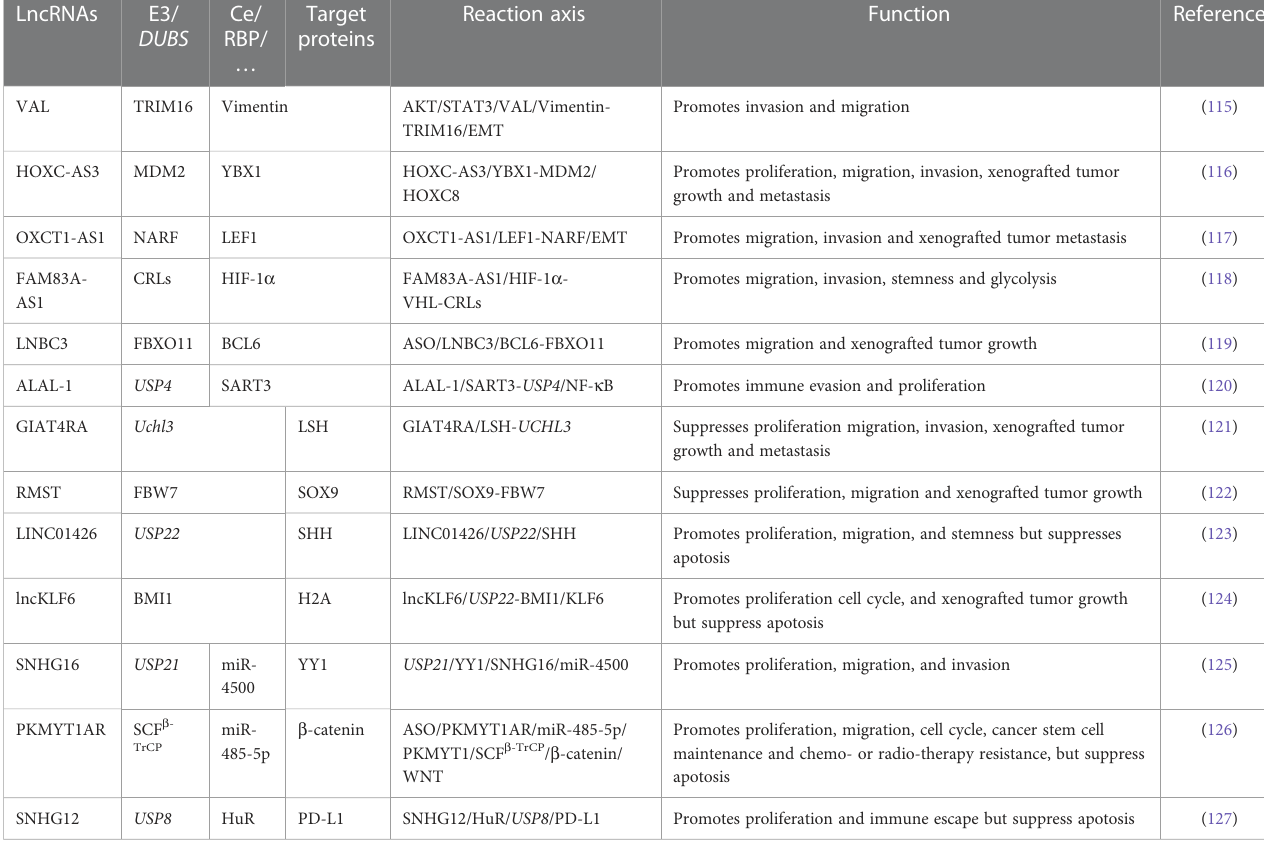
TABLE 2 The interaction between lncRNAs and UPS in NSCLC(when a protein acts as two roles, the two charts were merged).